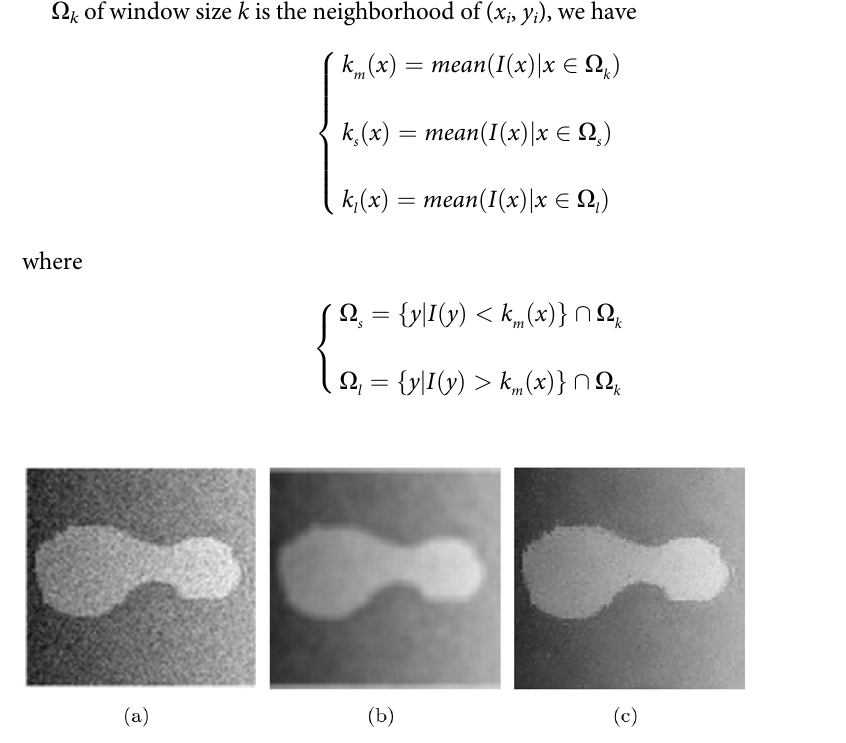
Fig 3. Comparison between the Bilateral filtering and the Gaussian filtering for a synthetic image. (a) Original image. (b) The Gaussian filtering. (c) The Bilateral filtering.